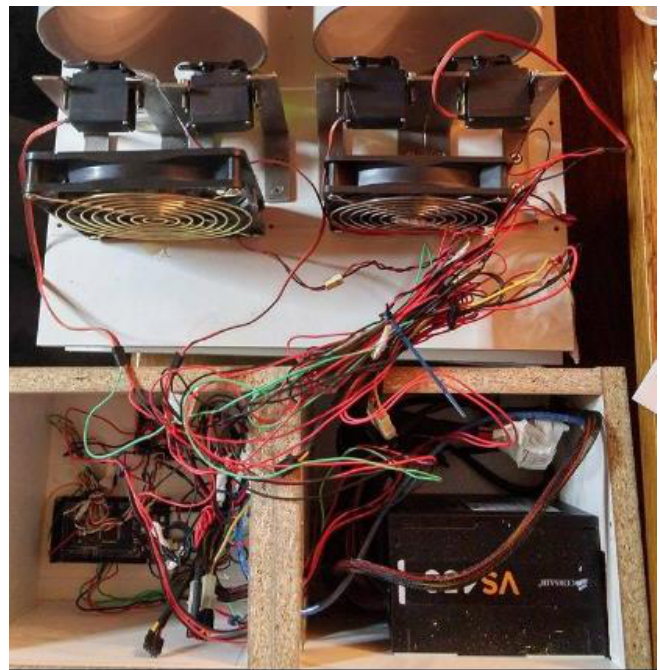
Figure 4. Sensors 2020 , 20 , x FOR PEER REVIEW